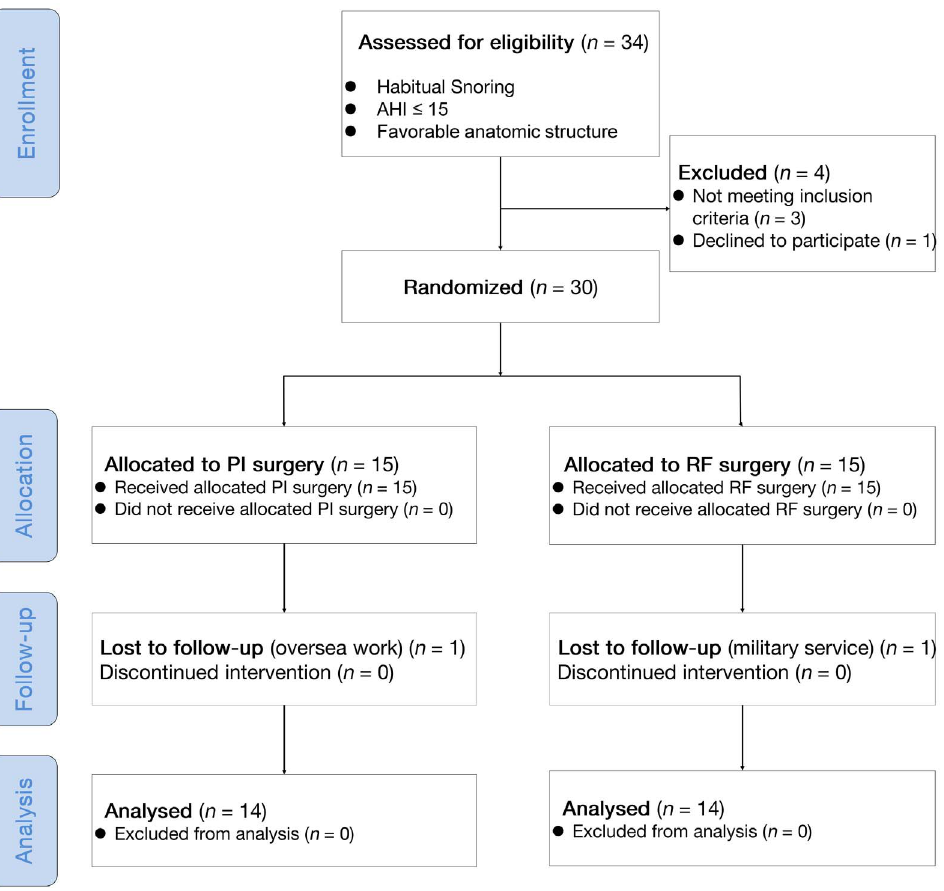
Figure 1. Schematic diagram (CONSORT 2010 flowchart diagram) summarizing the study design. AHI: apnea-hypopnea index. PI: palatal implant; RF, radiofrequency. SOS: snoring outcomes survey. VAS: visual analogue scale.